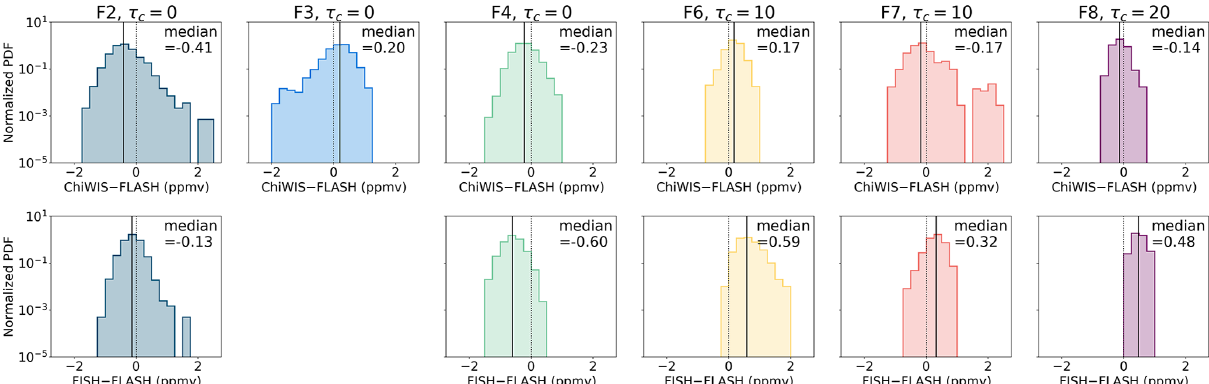
Figure 4. Normalized PDF of absolute differences in paired clear-sky observations below 10ppmv for FLASH and ChiWIS (top row) or FISH (bottom row). The 10ppmv cutoff is set by FLASH. FISH did not report measurements for F3. The time lag τ c applied to the cloud flag for each flight is indicated in the title. The dotted line shows zero mean difference, and the solid line shows the median difference for each flight; this value is marked in the top right corner of each subplot. On F2 and F4, FISH median difference from FLASH is negative, while on F6–F8 it is positive; this trend is also distinguishable in Fig. 3. The spread in measurement differences between paired observations on each flight is consistent with the joint precision of the instruments ( ≈ 0 . 2–0.4ppmv).